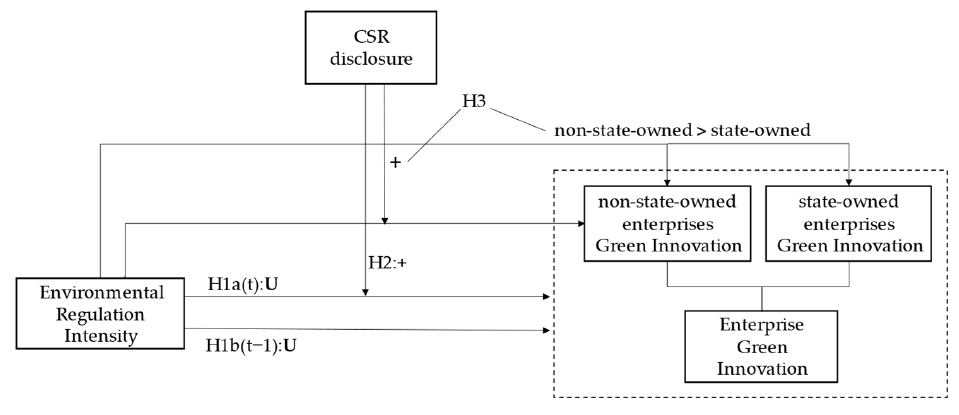
Figure 1. Theoretical